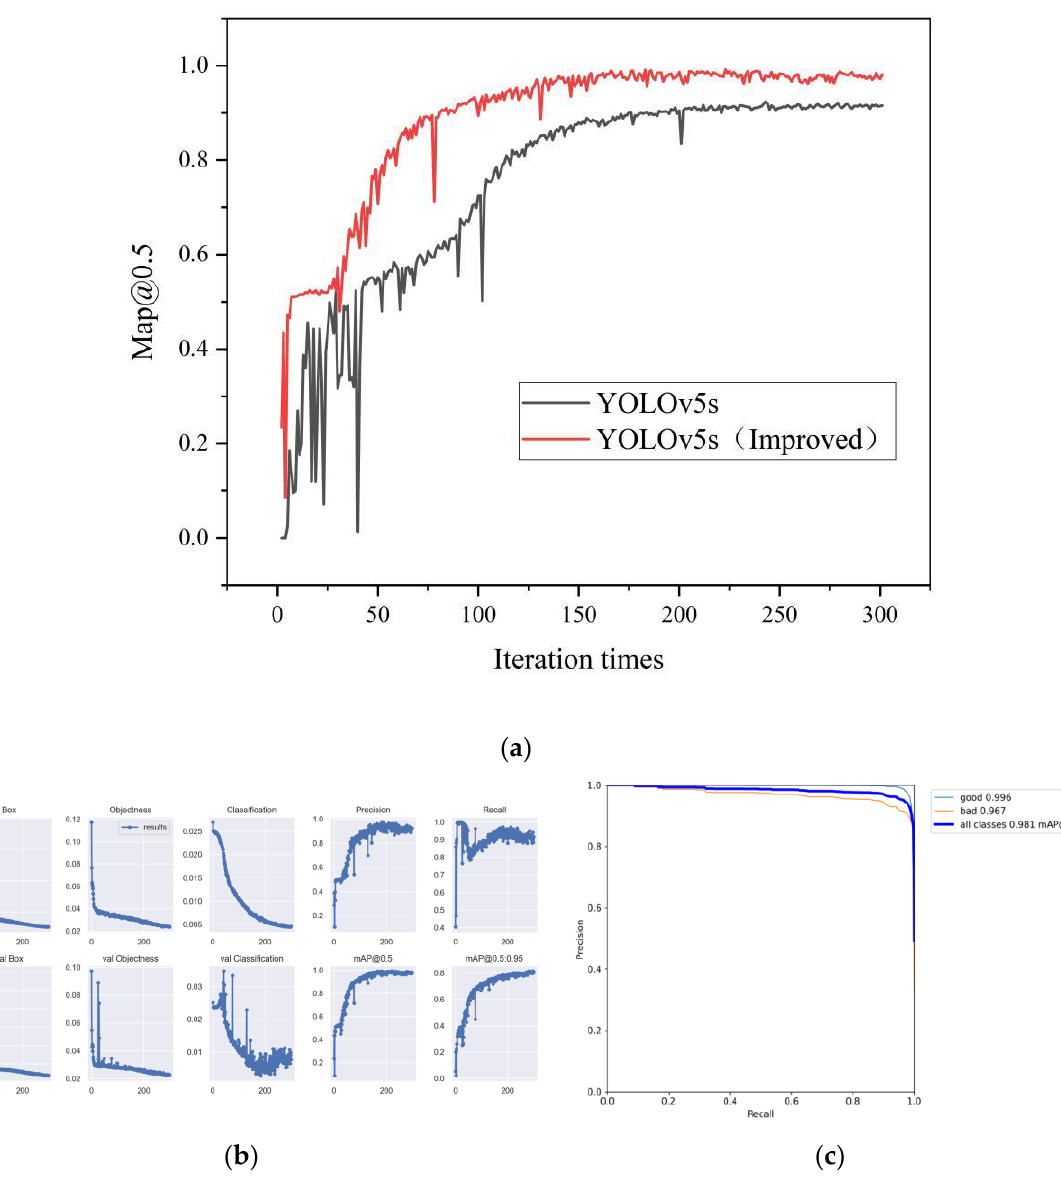
Figure 10. Model map comparison diagram. ( a ) Model comparison before and after YOLOv5s improvement; ( b )YOLOv5s improved training results; ( c )YOLOv5 s improved PR curve diagram.